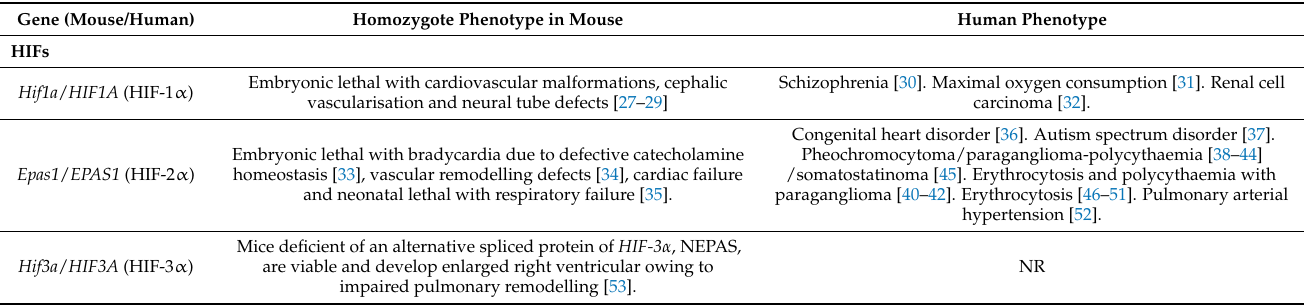
Table 2. Available mice and human mutations phenotypes for HIF and